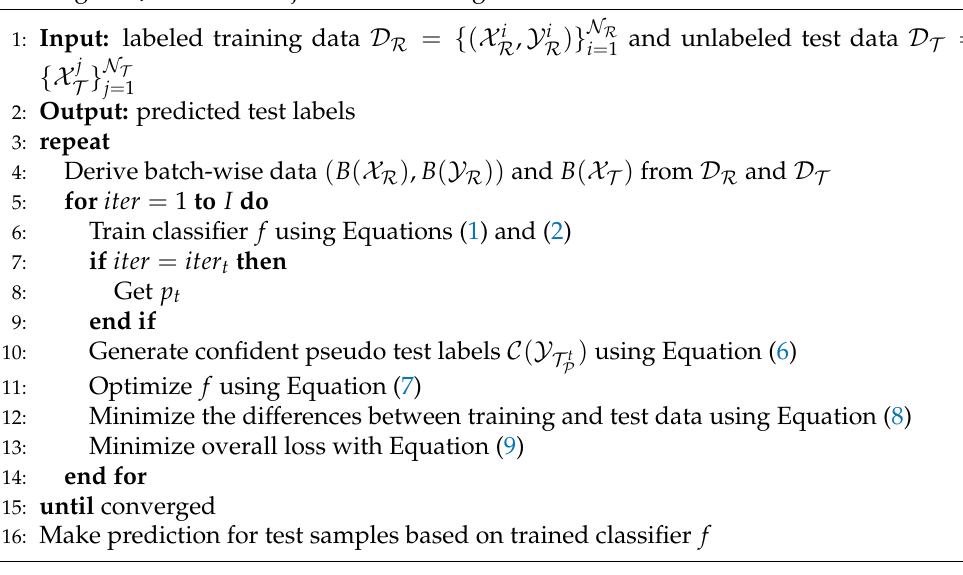
, and T is the number of adjustment t = 1